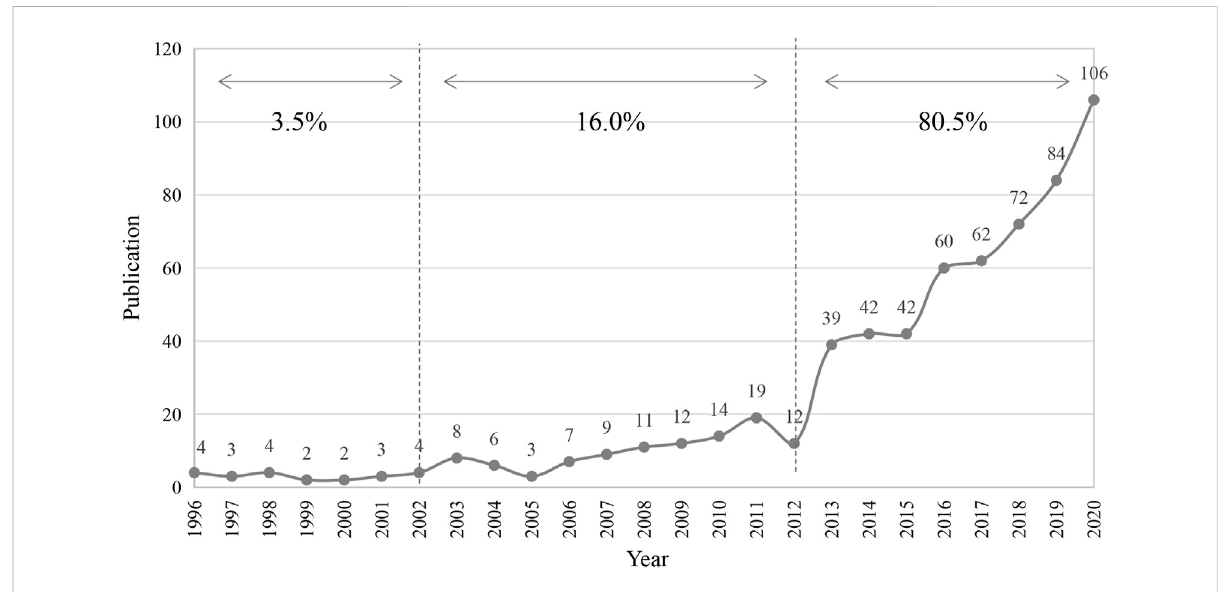
FIGURE 1 Distribution of articles by publication year from 1996 to 2020.